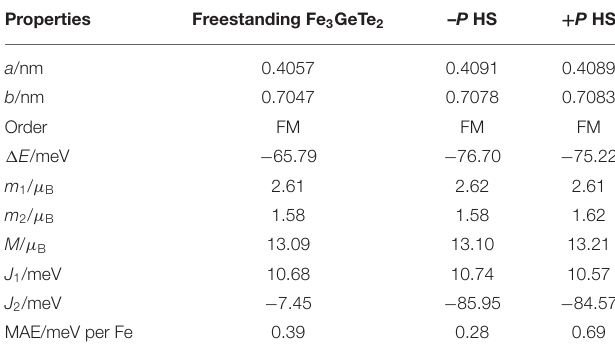
TABLE 1 | The calculated lattice parameters a, b, the magnetic order, the energy difference between the FM order and the lowest-energy AFM order ( 1 E E FM E AFM ), the magnetic moments m 1 , m 2 of the two inequivalent Fe atoms, the − net magnetization M , the magnetic anisotropy energy (MAE) per Fe atom, the exchange parameters J 1 and J 2 of the freestanding Fe 3 GeTe 2 monolayer and the